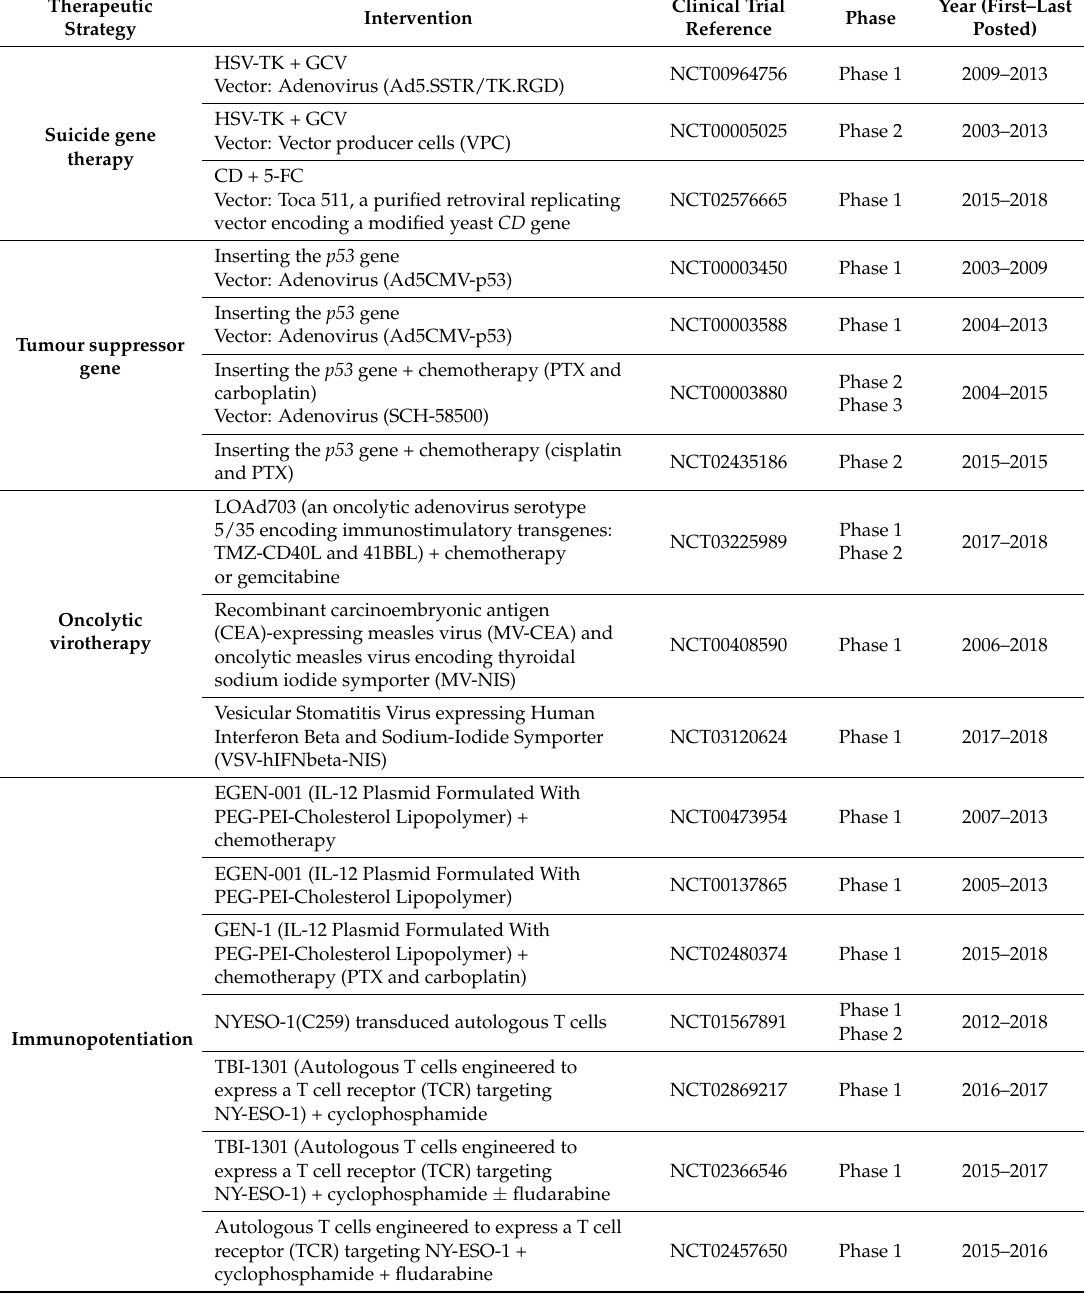
Table 3. Current ovarian cancer gene therapy clinical trials available in [114] “clinicaltrials.gov” until May 2018 using the terms “ovarian cancer” and “gene therapy” as key words. Therapeutic